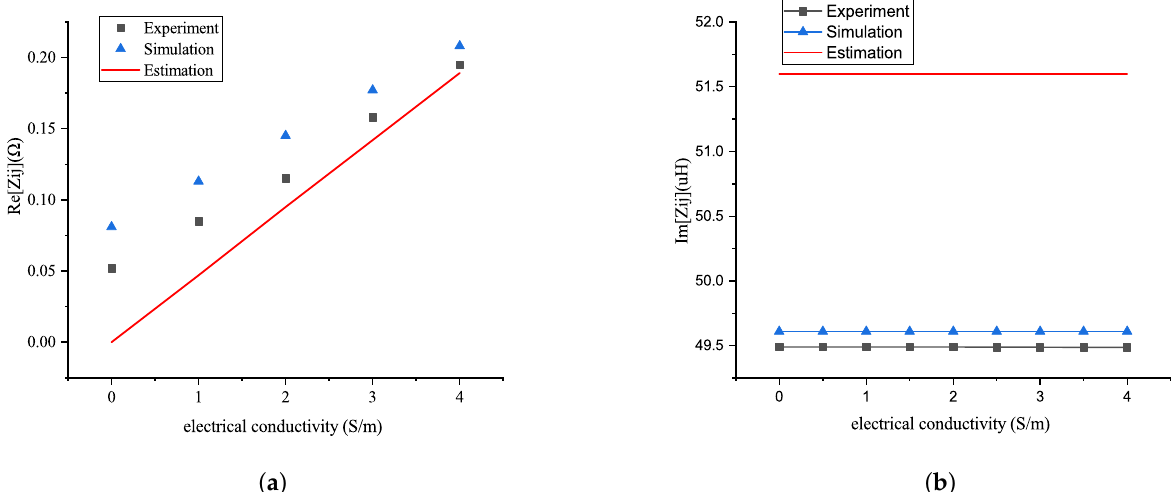
Figure 6. ( a ) The real part of mutual impedance of two coils as a function of the conductivity of media. ( b ) The imaginary part of mutual impedance of two coils as a function of the conductivity of